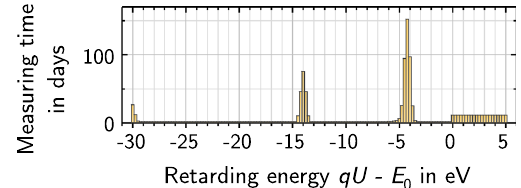
Fig. 21 The measuring time Δ t k attributed to various retarding poten- tial settings U k in a more sparse, statistically optimized distribution